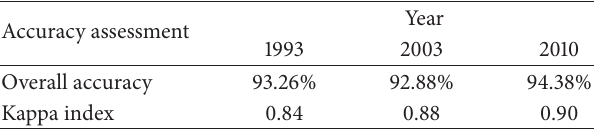
Figure 3: Color indexed LULC classification map from the SPOT series of satellites (blue: water body; green: vegetation; purple: non- vegetation). (a) 1993 SPOT-2; (b) 2003 SPOT-5; (c) 2010 SPOT-5. Table 1: The accuracy assessment of images classification.